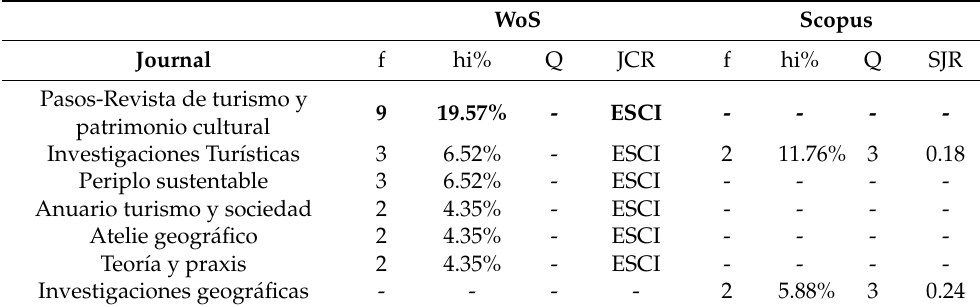
Table 8. Number of articles per journal according to WoS and Scopus databases.